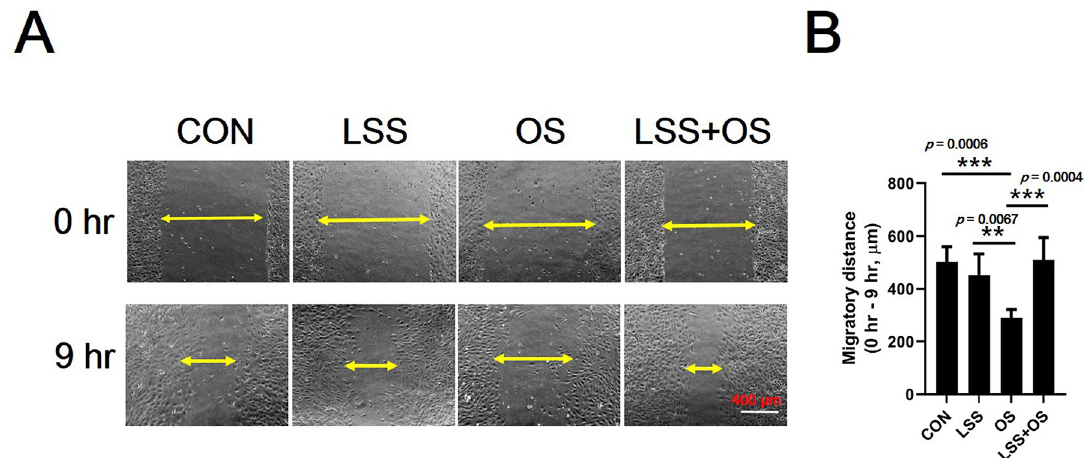
Fig 8. Comparison of wound healing ability of vascular ECs after senescence simulated by oxidative stress and exercise simulated by laminar shear stress in vitro . (A) 10 × magnification microscopic images of scratch wound healing assay. ( B) Migratory distance. LSS: Laminar shear stress; OS: Oxidative stress. All data are presented as the mean ± SD, � p < 0.01 and ��� p < 0.001.